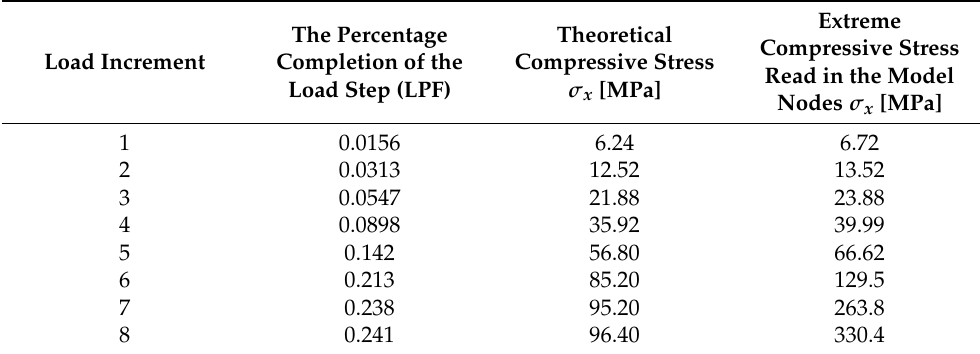
Table 1. The comparison of compressive stress in the facing for the load increments of the numerical model.